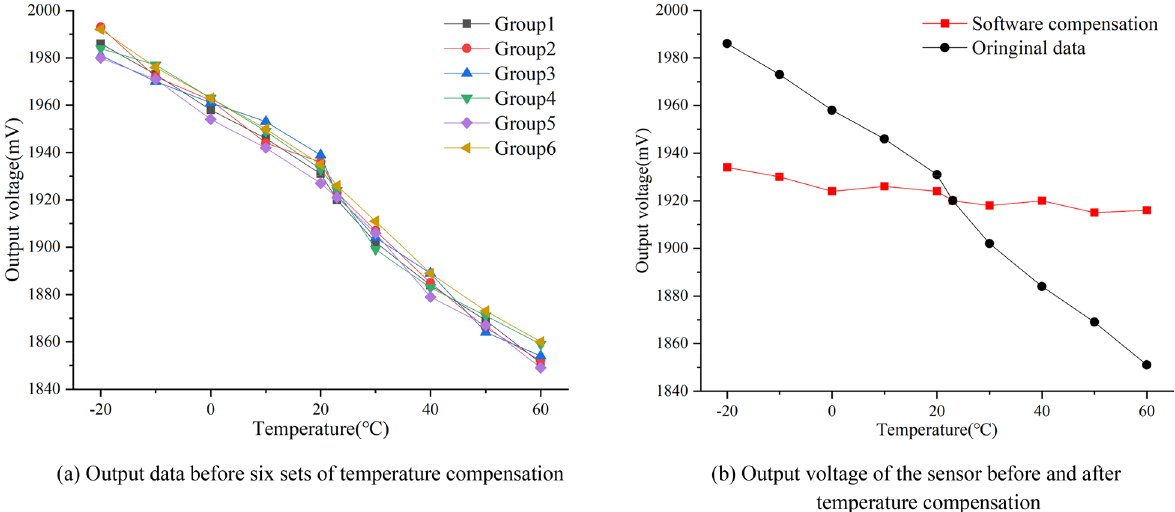
Figure 13. Comparison of the output voltage of the sensor before and after temperature compensation (( a , b ) were generated by Origin 2016 × 64 (https:// www. origi nlab. com/